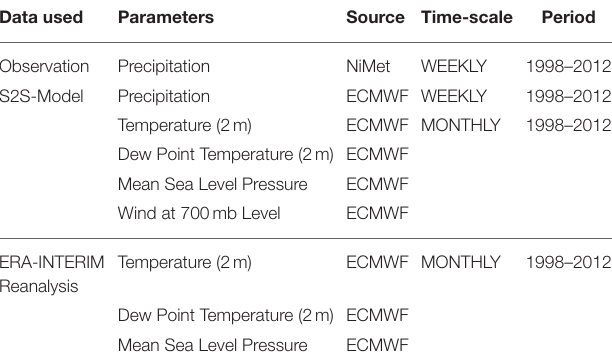
TABLE 2 | Summary of data used in this study.